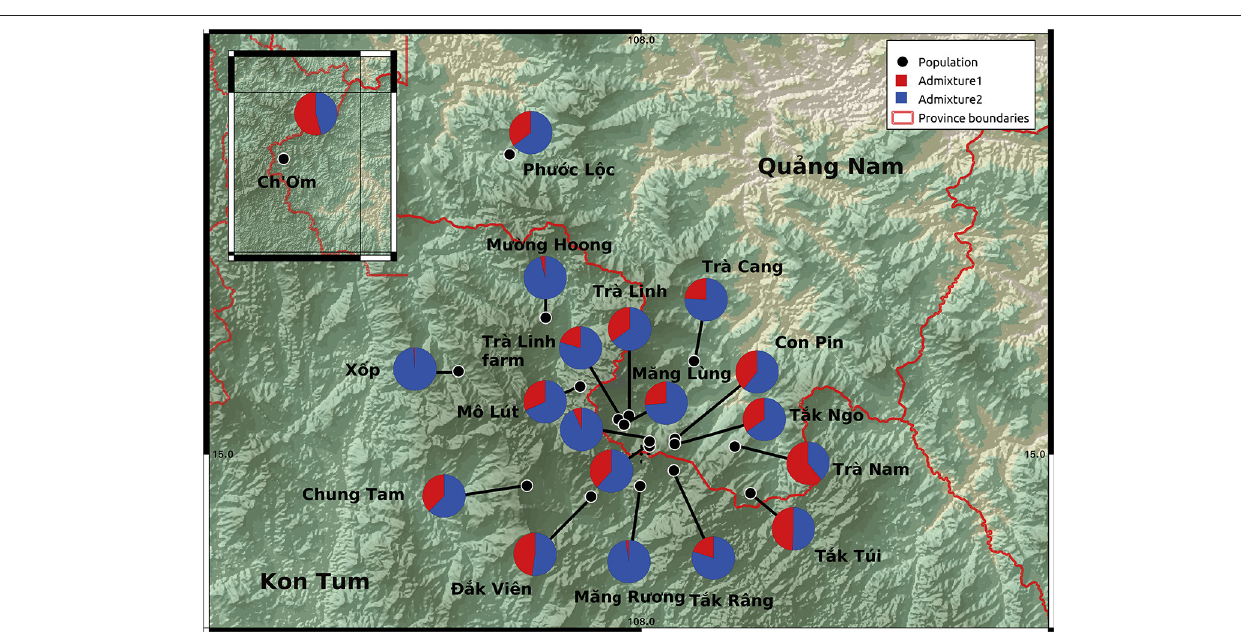
FIGURE 3 | Admixture plots of Panax vietnamensis per population for K = 2. Columns topped with a black dot constitute wild samples. No consistent differences in the admixture patterns were detected between sites.